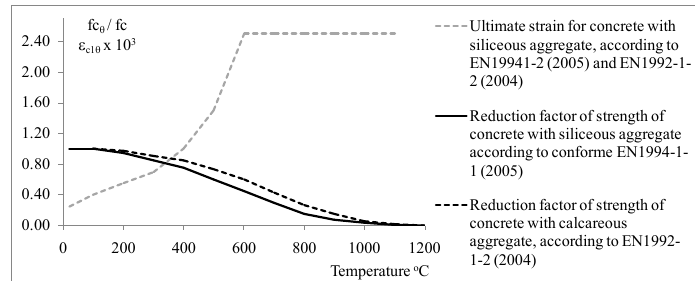
Figure 4. Reduction of compressive strength of concrete as function of